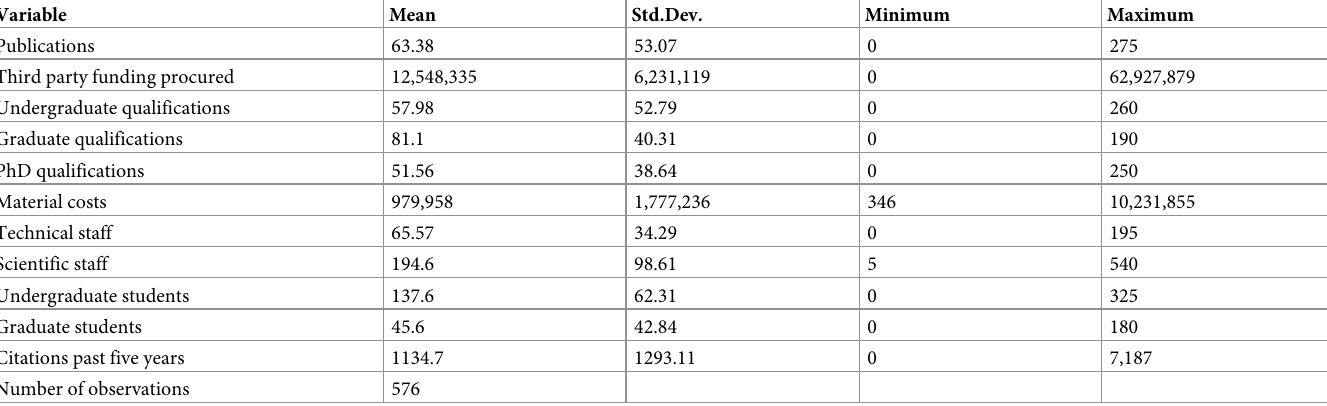
Table 5. Descriptive statistics for the biology sample before